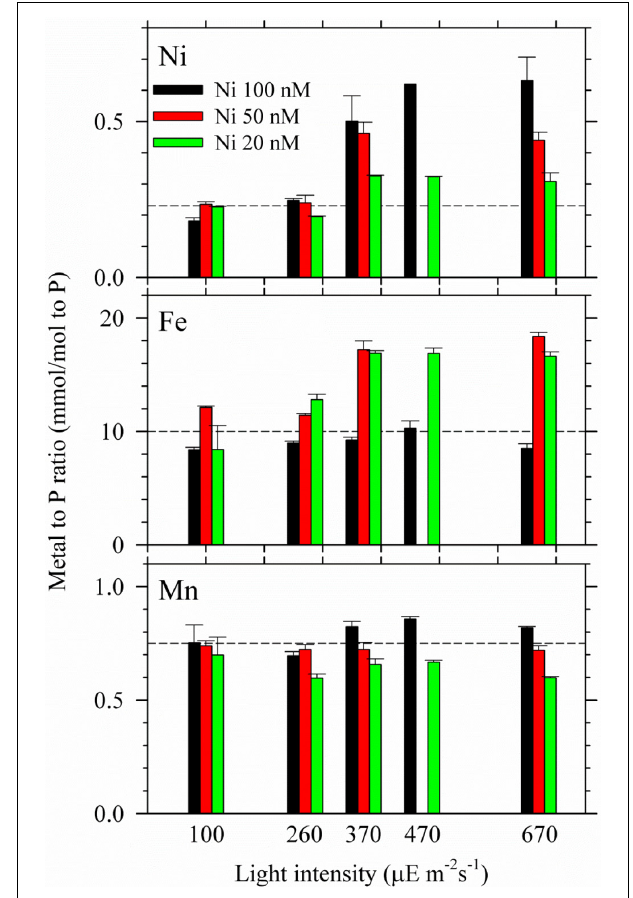
FIGURE 3 | Intracellular Ni, Fe, and Mn quotas in Trichodesmium grown under the multiple light and Ni conditions. The trace metal quotas were all normalized to intracellular P concentrations. Cells were harvested during the late exponential phase.The error bar stands for analytical precision (one standard deviation of three replicate